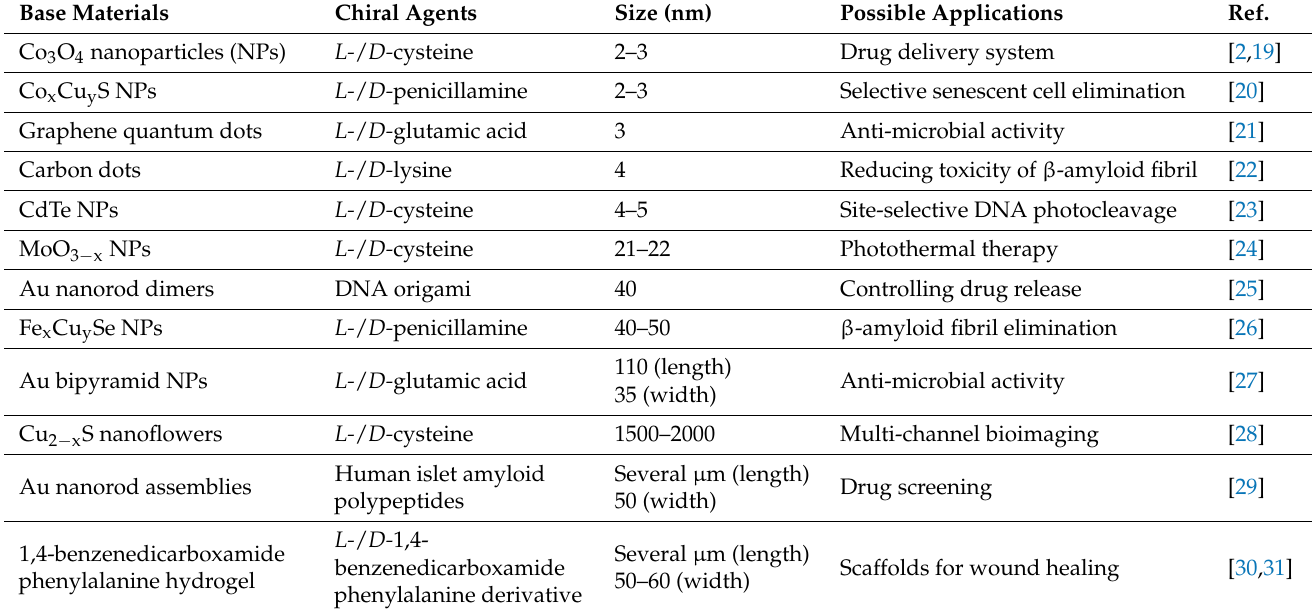
Table 1. Chiral biomaterials with various scales and their possible